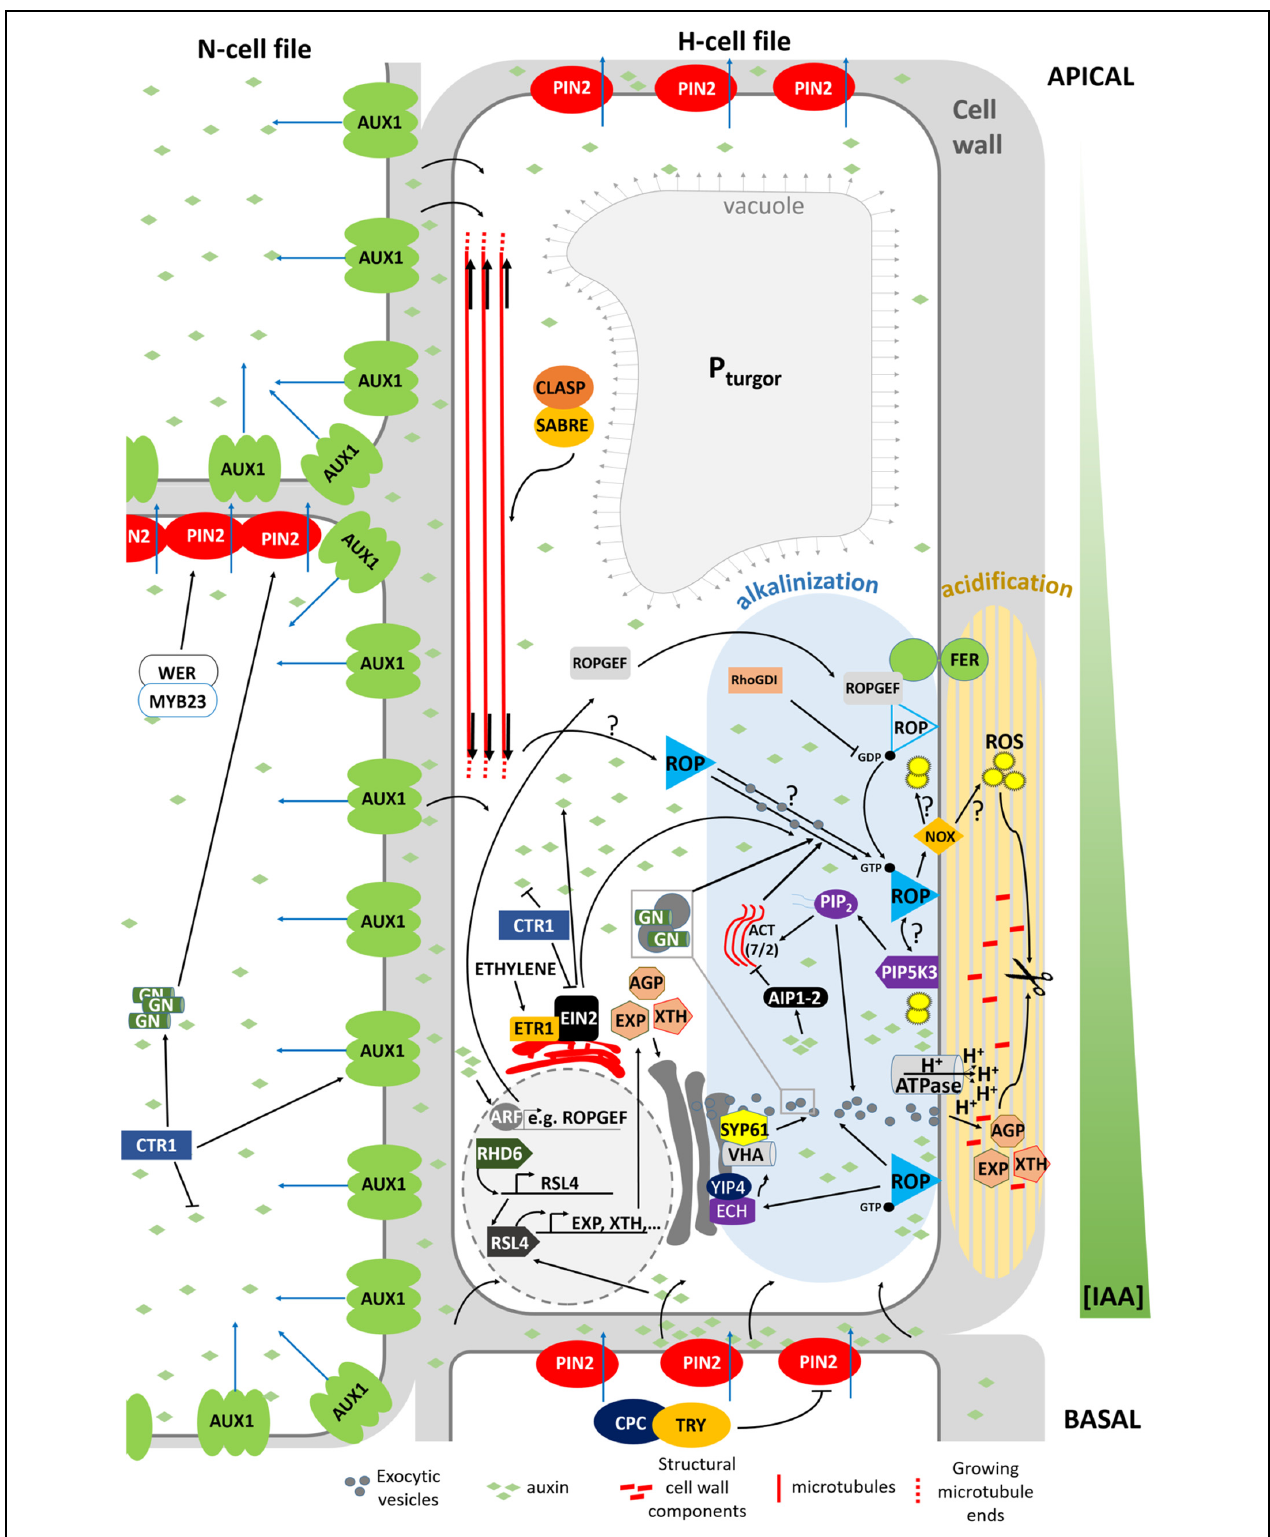
FIGURE 3 | Model summarizing the mechanism determining planar polarity within the Arabidopsis trichoblast. FER, FERONIA; GN, GNOM; ACT, actin; VHA, VHA-A1; NOX, NADPH OXIDASE, ROP, ROP GTPase. Blue arrows indicate active auxin transport. Black arrows crossing the PM refer to passive diffusion of